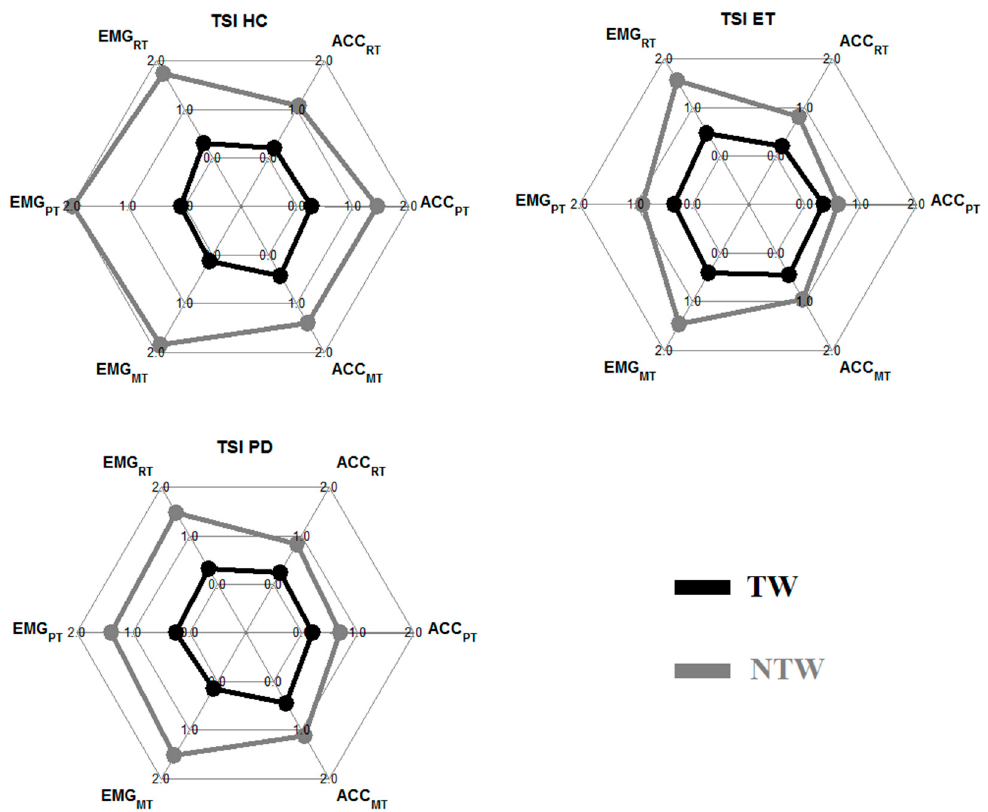
Figure 2. Group mean tremor stability index (TSI) of the healthy control (HC), essential tremor (ET), and Parkinson’s disease (PD) groups. In each spider plot on the left side are the results of the EMG data (top to bottom: RT, PT, and MT), and on the right side are the results of the accelerometer data. In black , the TW results are displayed, and in grey , the results of the NTW.